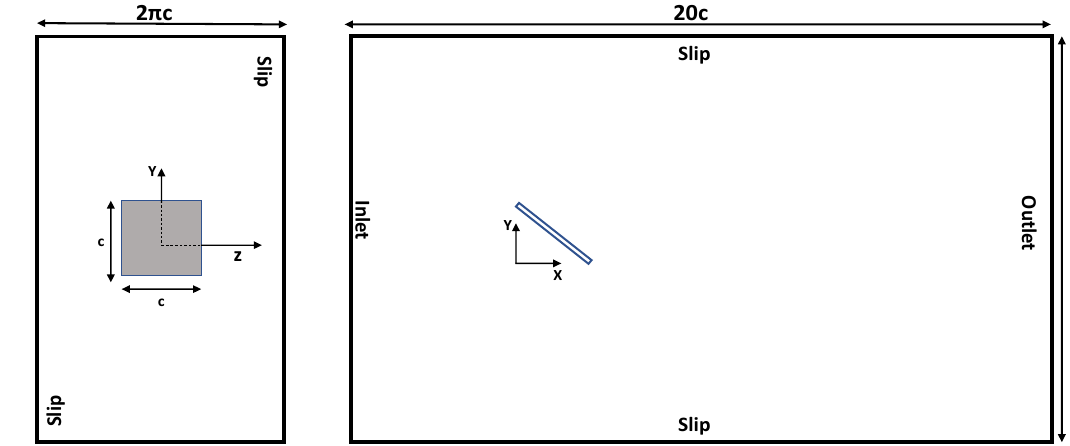
Figure 1. Schematic of the computational domain and boundary